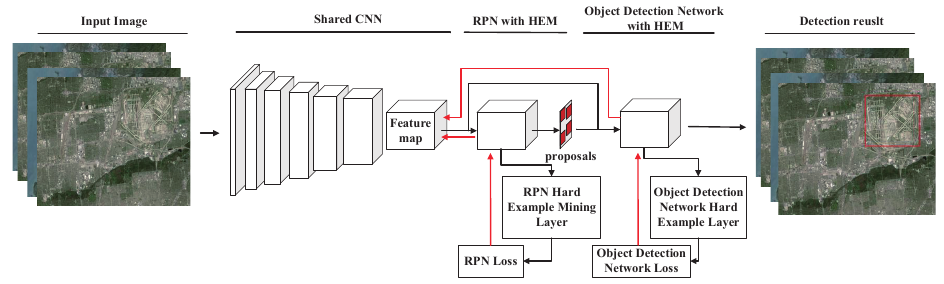
Figure 1. The flowchart of the proposed method. The red arrows indicate the direction of the backward